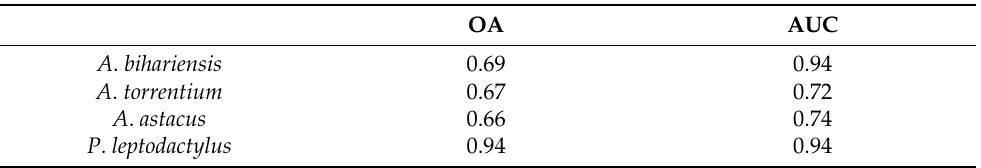
Table 3. Accuracy metrics for the final distribution maps (OA—overall accuracy; AUC—area under the